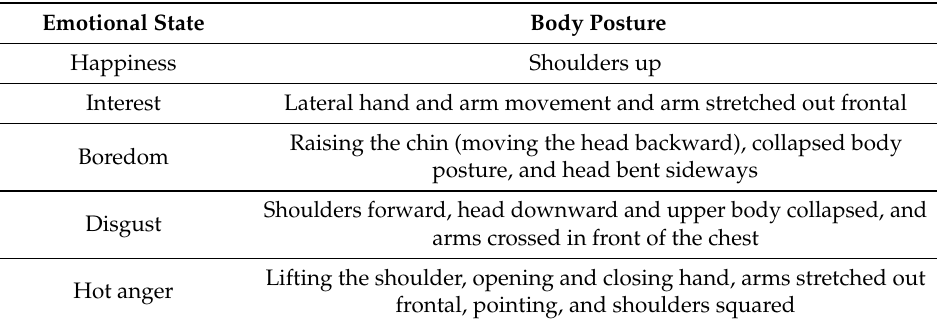
Table 1. Description of body postures based on emotional